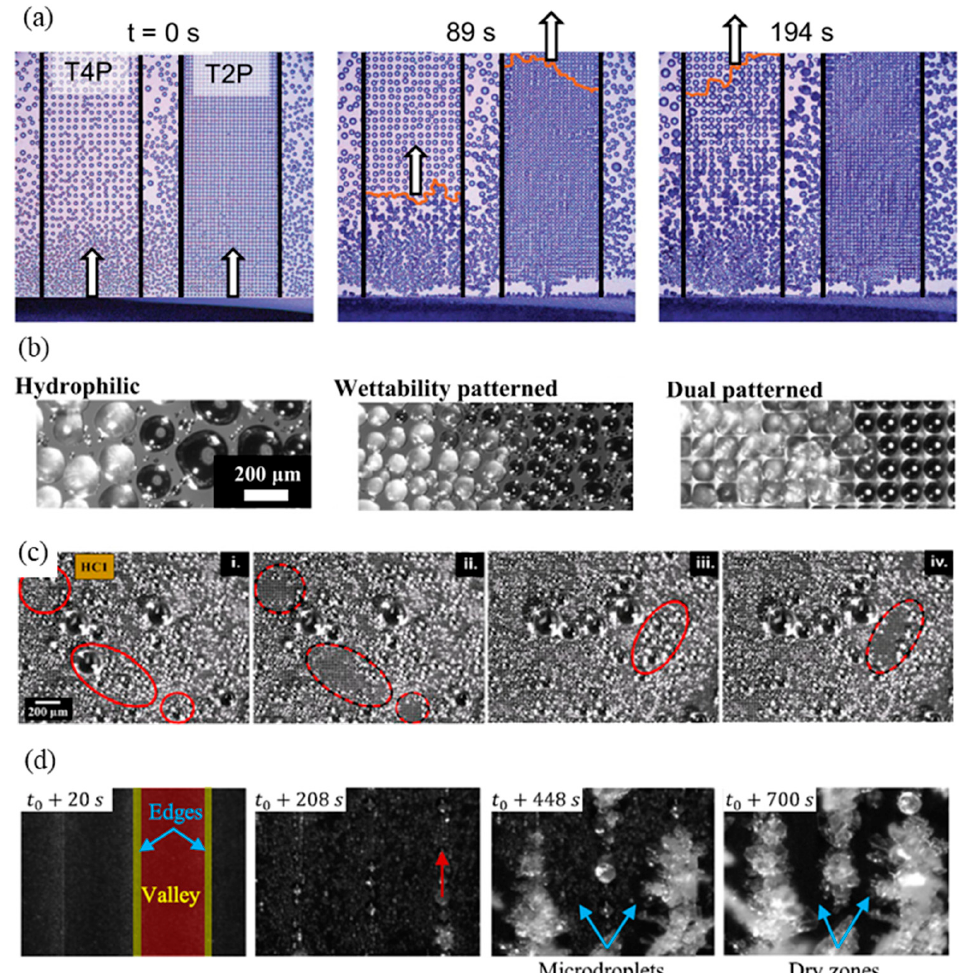
Figure 6. Freezing propagation dynamics on ( a ) the chemically patterned surface, Reprint from [21], Copyright 2016 with permission from Springer Nature. ( b )wettability/morphology patterned surface, Reprint from [39], Copyright 2017 with permission from Elsevier. ( c ) vertically aligned carbon nanotube based superhydrophobic surface, Reprinted with permission from [66], Copyright 2020 American Chemical Society. and ( d ) copper-based hierarchically structured surface, Reprint from [67], Copyright 2021 with permission from Elsevier.